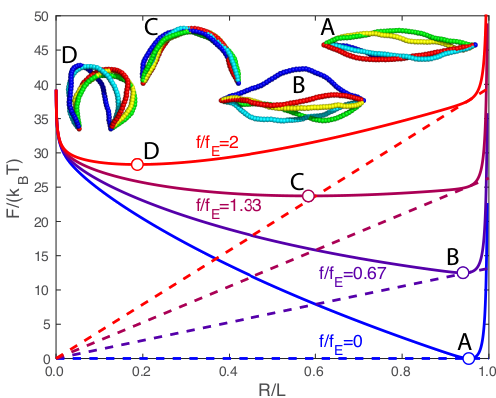
Figure 1. Free energy F as a function of end-to-end separation over contour length R / L for a semiflexible chain of length L / ( 2 l p ) = 0.25 at four different applied forces f / f E . Solid curves show the total free energy F , and the dashed lines indicate the force energy E f . Monte Carlo snapshots of the chain conformations at the free-energy minima are marked by the circles labeled A , B , C , and D